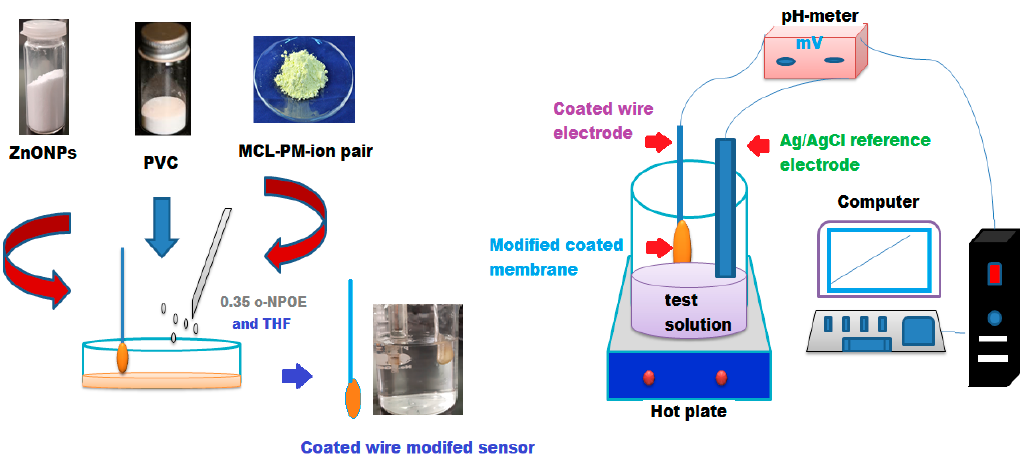
Figure 2. Illustrated the construction of the modified sensor and its potentiometric system.